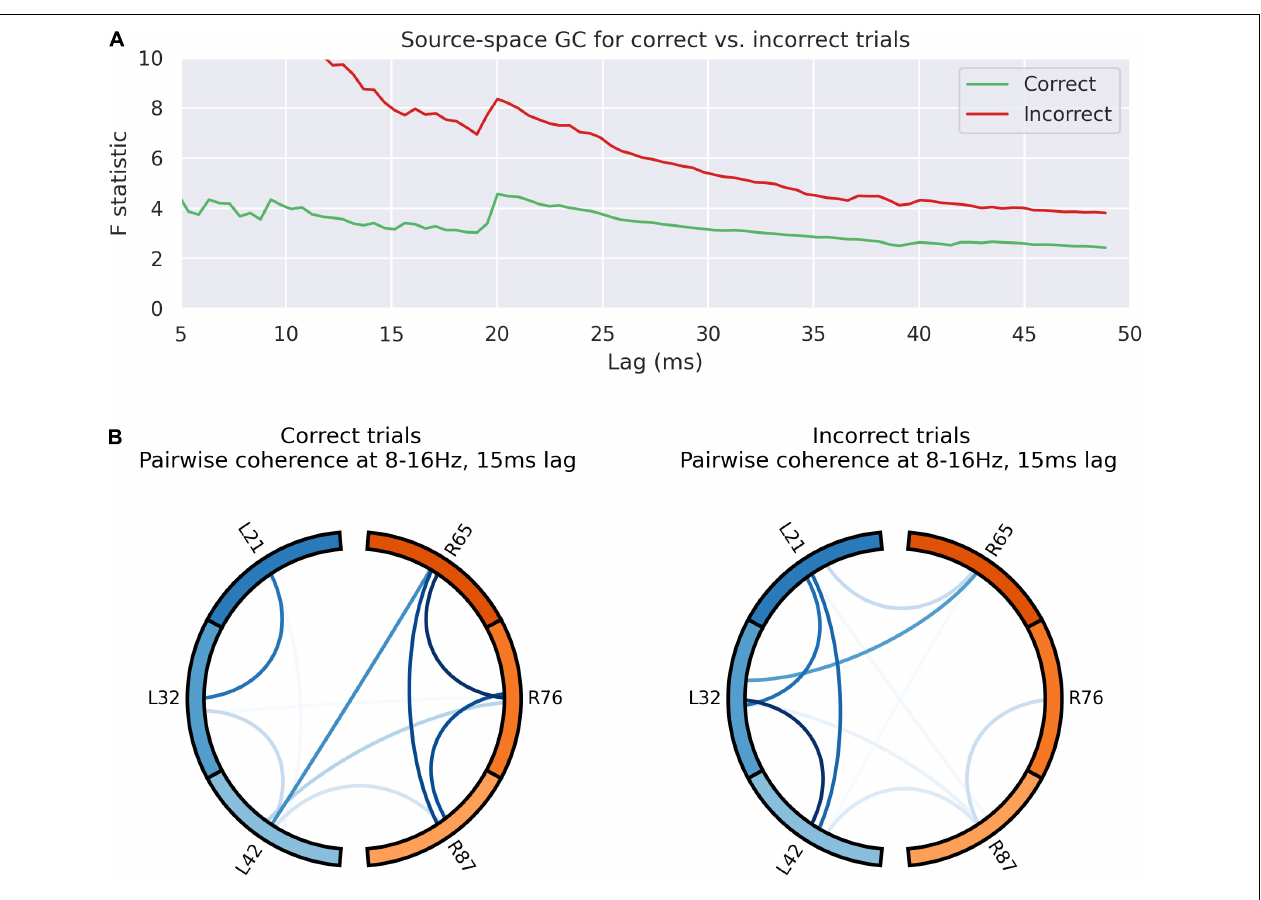
FIGURE 6 | Outcome valence alters information flow in the dACC prediction network. (A) Granger causality of activity sources for left to right communication in the 100–500 ms post-feedback window. The test statistic is consistently higher following incorrect trials, suggestive of greater left-to right communication following an error. There is a jump in the test statistic at 20 ms. This suggests transmission of an error-related signal from left to right following incorrect trials with a lag of 20 ms, consistent with other results. The overall high left to right communication seems to be largely driven by incorrect trials. (B) Pairwise coherence for all electrodes at 8–16 Hz with a 15 ms lag for correct and incorrect trials. This lag was selected based on the analysis of coherence data across all trials (see Figures 5B,D ). The overall patterns of communication are visibly different between trials, as confirmed by principal component analysis ( p < 0.0001), suggesting different network dynamics based on the nature of the outcome